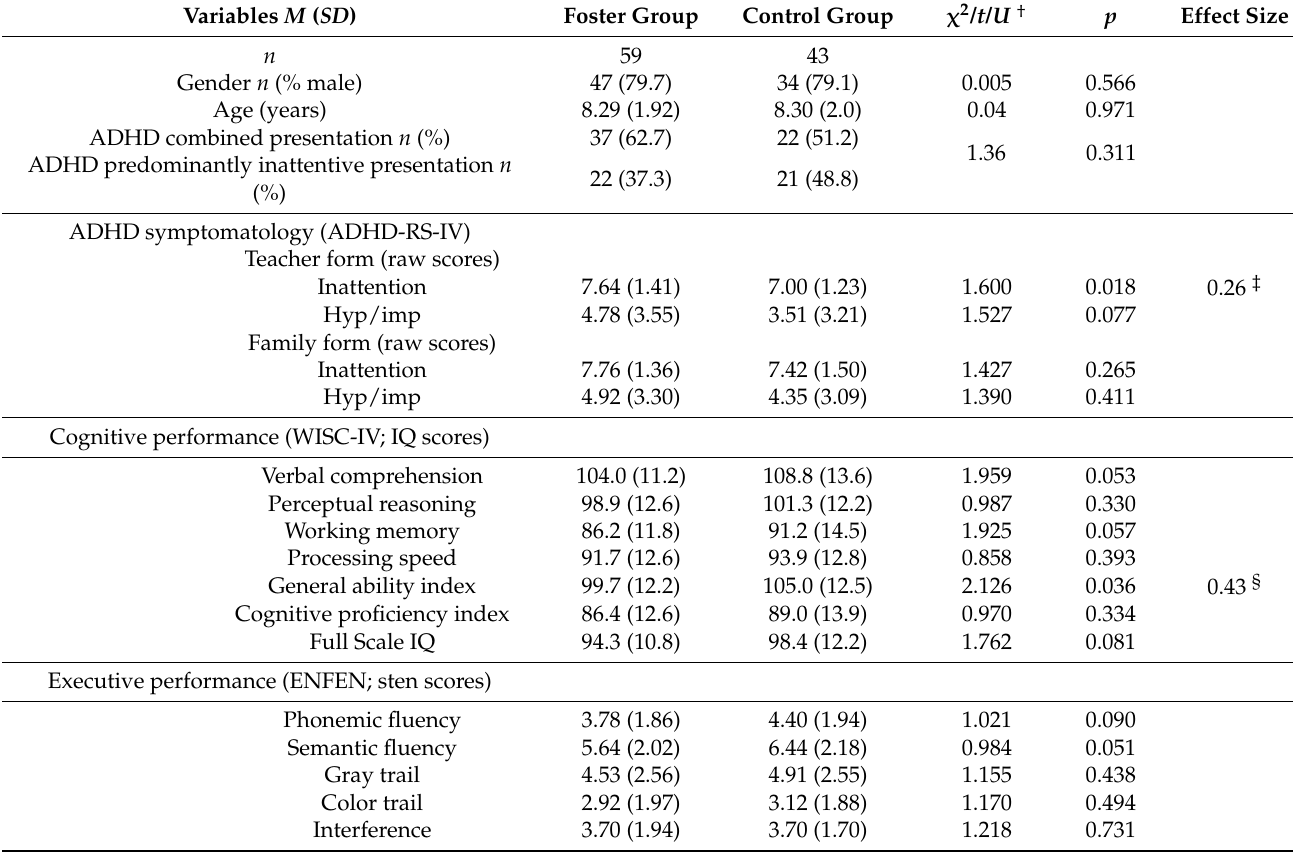
Table 1. Comparisons between children in foster care and control groups for demographic information, ADHD symptoma- tology, cognitive and executive